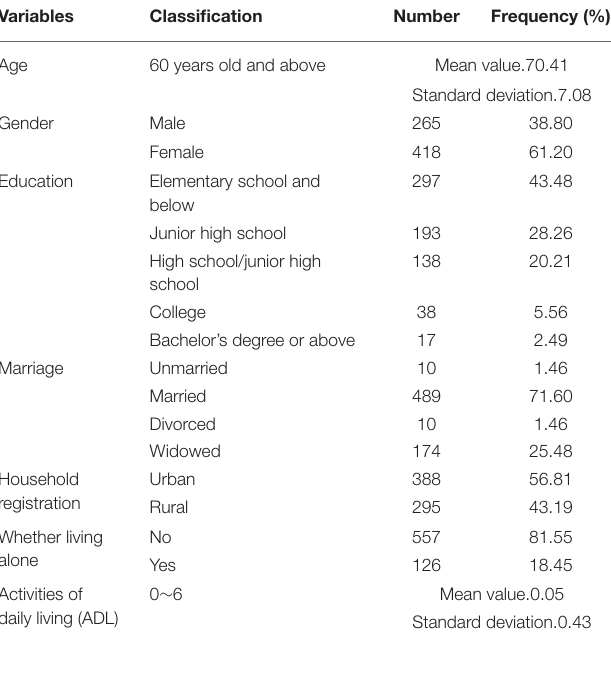
TABLE 3 | Descriptive statistics.